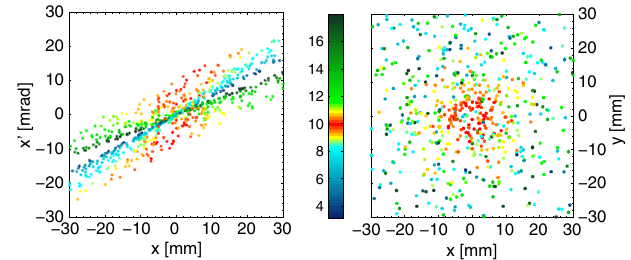
energy interval of ð 9 : 8 (cid:4) 0 : 5 Þ MeV for the shot shown in Fig. 3.